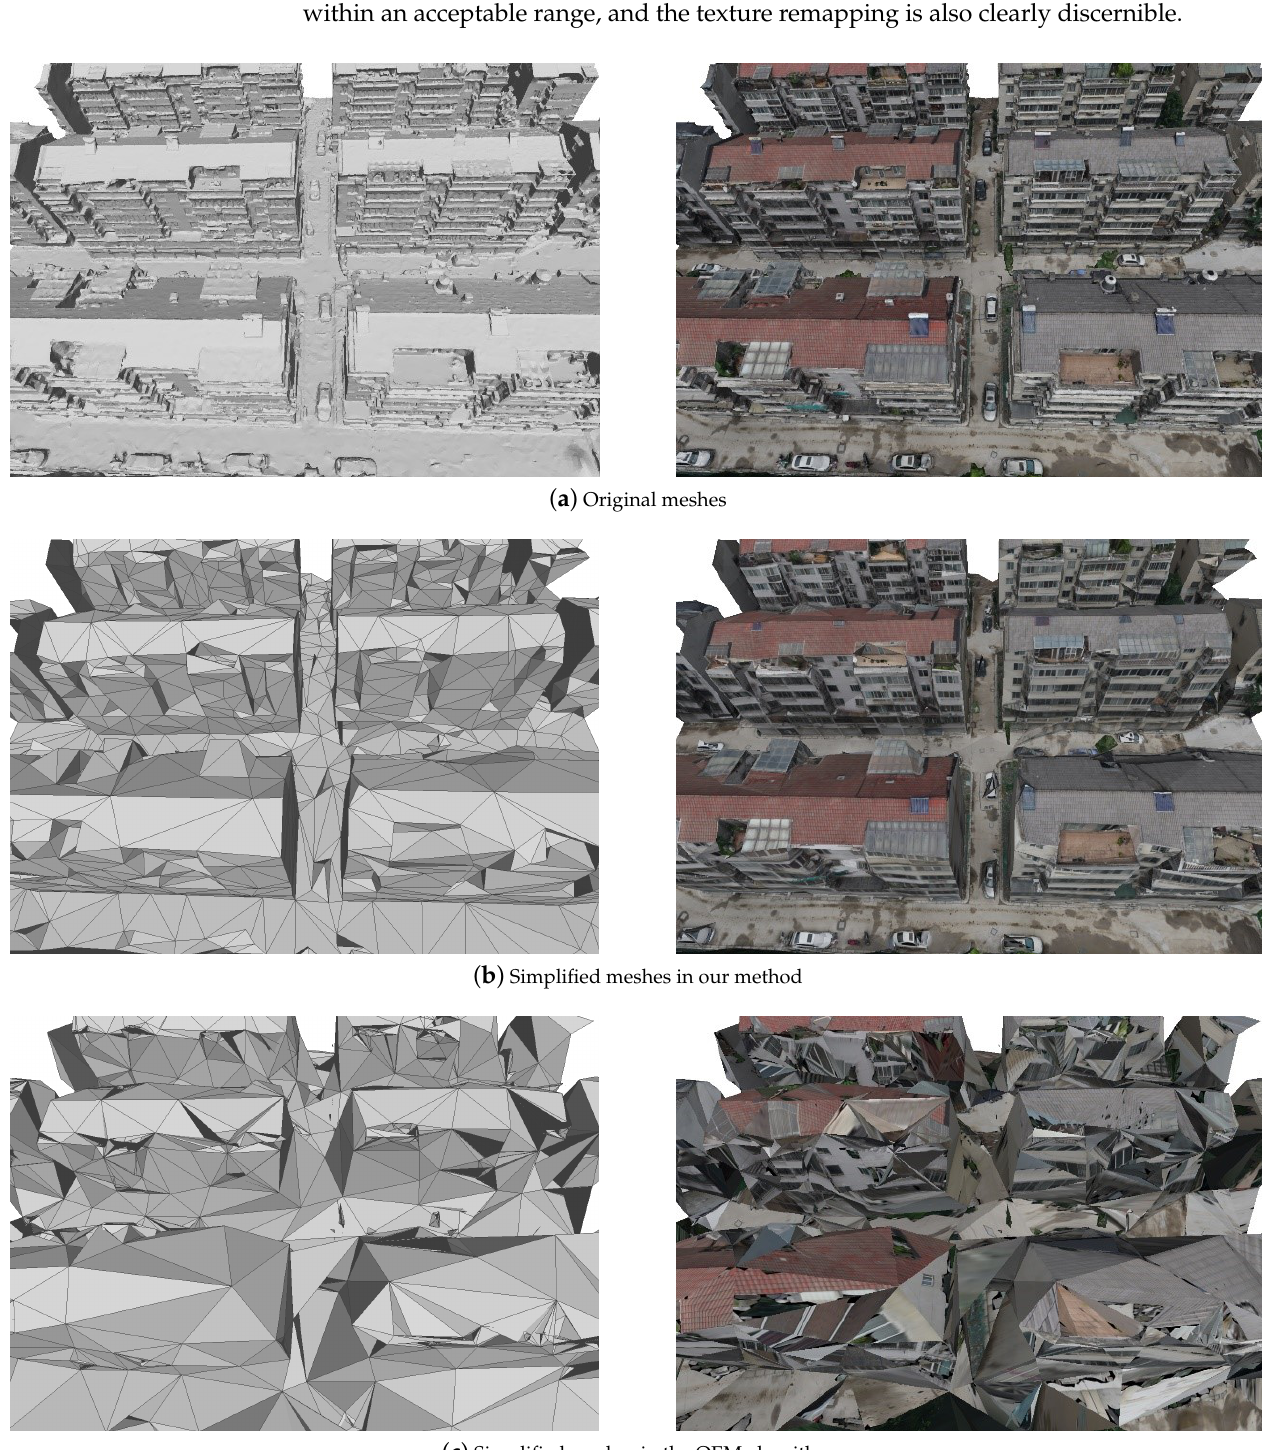
Figure 13. Comparison of the simplification results in our method and the QEM algorithm. ( a ) Orig- inal meshes (1,841,516 faces). ( b ) Simplified meshes in our method at the simplification rate of 99.8% (4280 faces). ( c ) Simplified meshes in the QEM algorithm at the simplification rate of 99.8% (4280